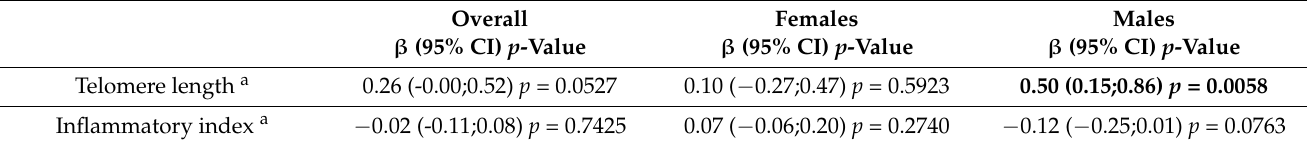
Table 3. Cross-sectional associations of telomere length and inflammatory index with cognitive function at T3, overall and by sex.